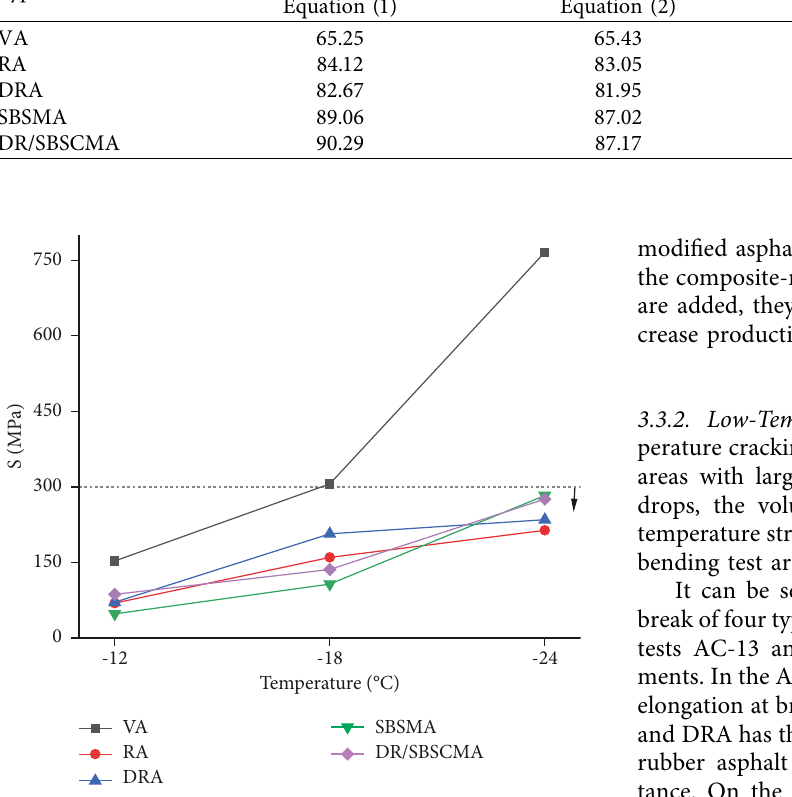
Figure 11: Creep stiffness modulus test